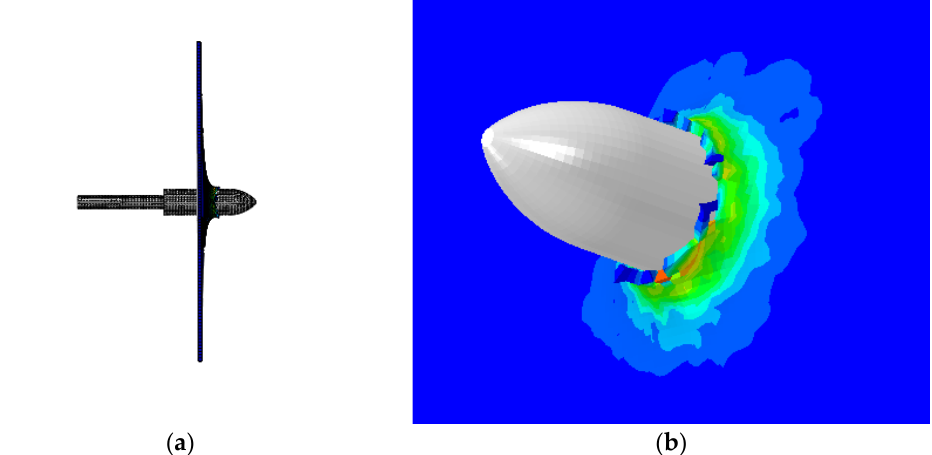
Figure 6. Details of target plate damage for a launch speed of 42 m/s.